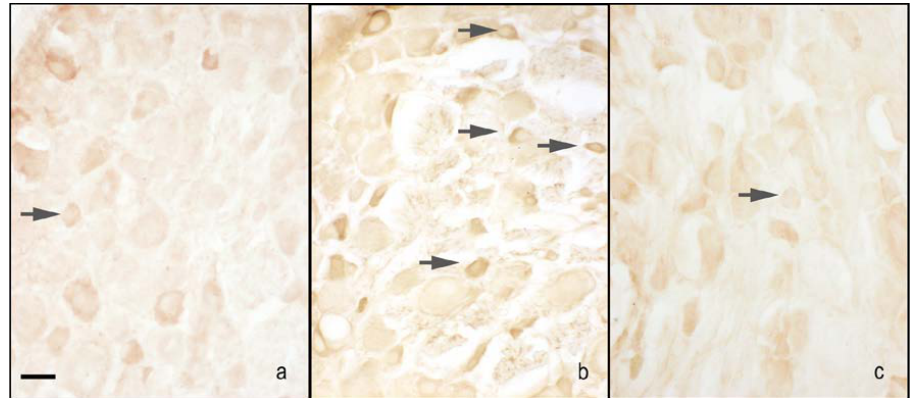
with melatonin (10 mg/kg) (CCI + MEL10). Data represent means ± SEM, ° p < 0.05 vs SHAM + V, # p < 0.05 vs CCI + V.